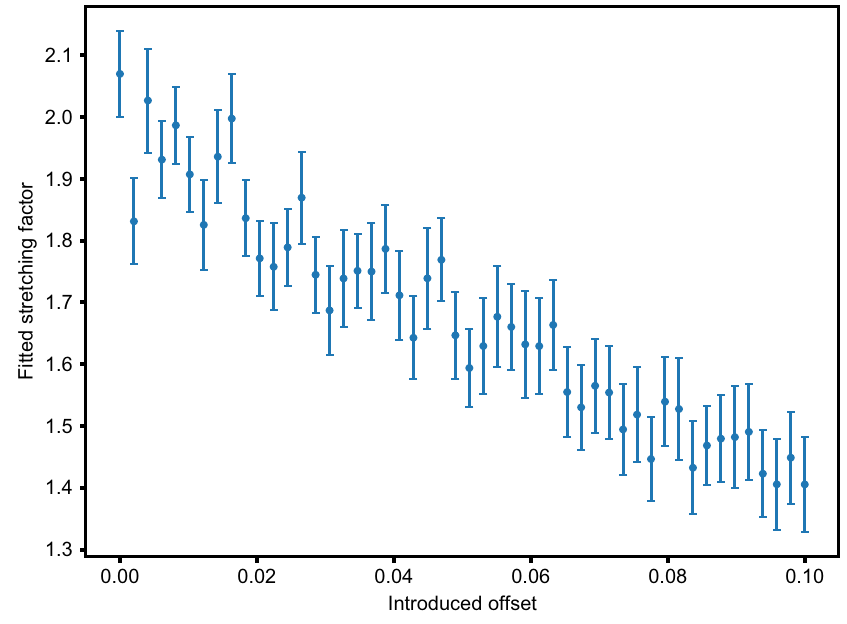
FIG. 17. Lowering of stretching factors with introduced offset. In simulated data with an introduced offset, the fitted values of n underestimate the true value of n = 2 systematically, with lower values of n fit- ted for larger introduced offsets. The data are fit assuming an offset d = 0.